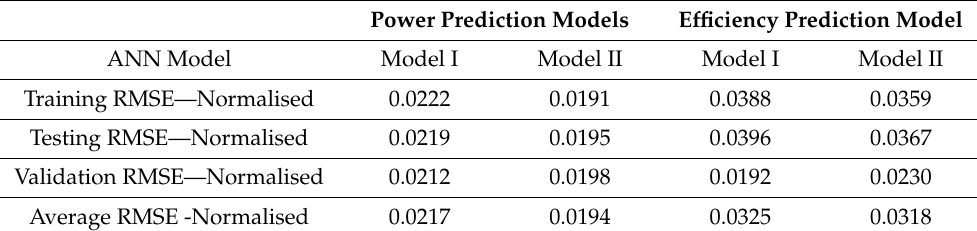
Table 4. Validation metrics using RMSE to evaluate the developed prediction models. Power Prediction Models Efficiency Prediction